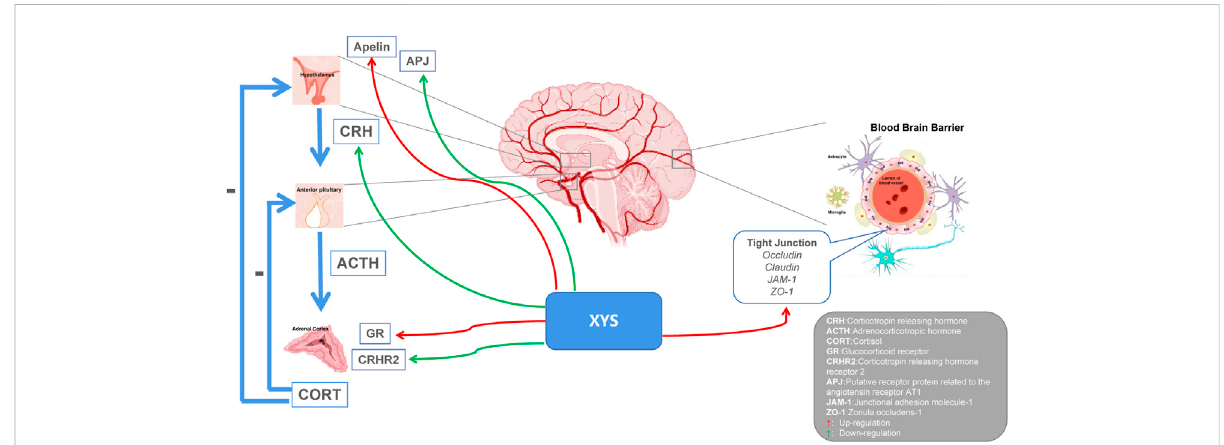
FIGURE 3 Potential relationship between Xiaoyaosan, depression and HPA axis. Xiaoyaosan can up-regulate the level of apelin in the hypothalamus and down-regulate the level of APJ in the hypothalamus. Down-regulation of CRH and CRHR2 levels, up-regulation of GR expression, and regulation of HPA axis hyperactivity. Elevate the expression of tight junction-related genes and reverse the damage of glucocorticoids to the permeability of the blood-brain barrier. Red arrows indicate upregulation. Green arrows indicate downregulation.